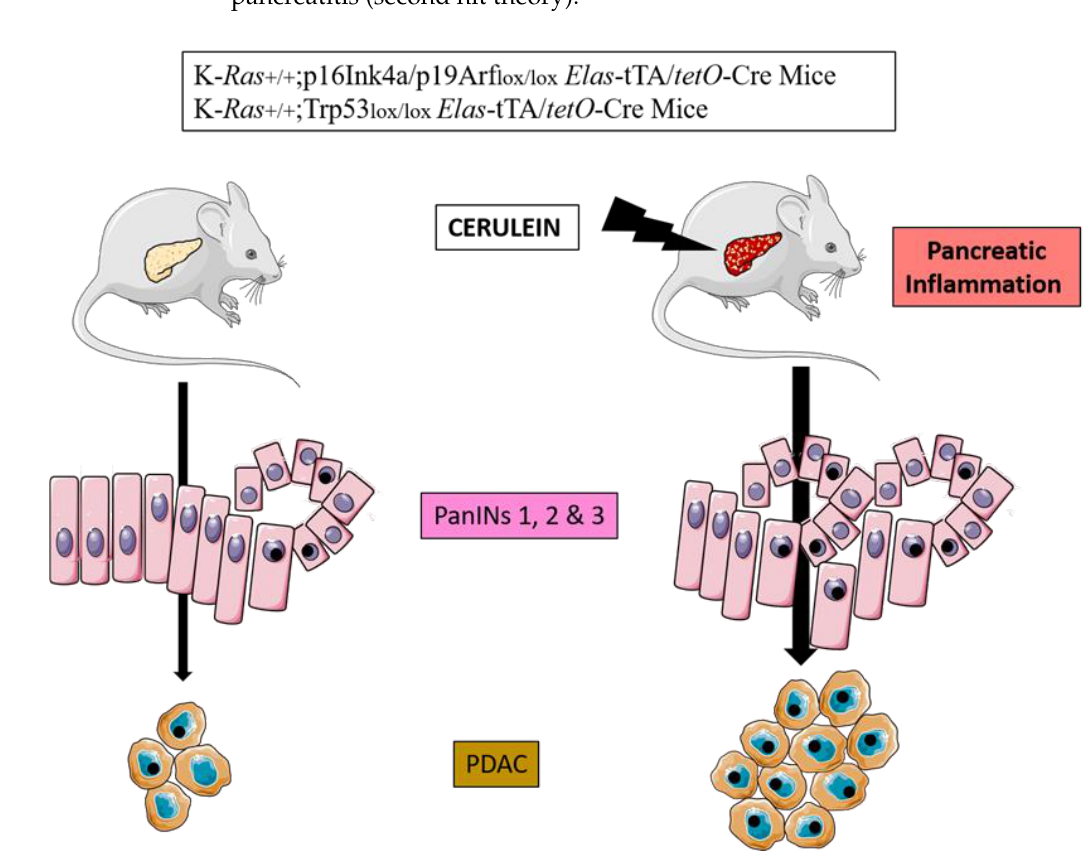
Figure 2. Cerulein experimental model of pancreatic carcinogenesis in genetically engineered mice. Pancreatic inflammation induced by cerulein injections increases the burden of PanINs and PDAC in transgenic mice bearing KRAS and p16INK4a or Trp53 mutations.